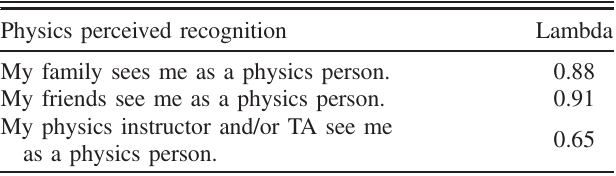
TABLE I. Physics perceived recognition survey